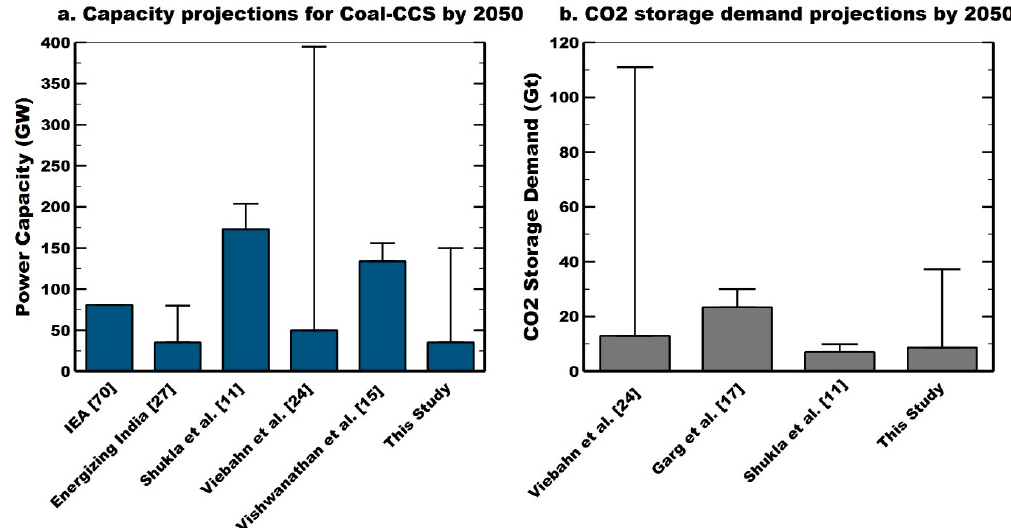
Figure 2. Coal-CCS pathways 2050: ( a ) Capacity projections for Coal-CCS in India by 2050 (note: Energizing India [27] projection is for 2047); ( b ) Projections for CO 2 storage demand in India by 2050.